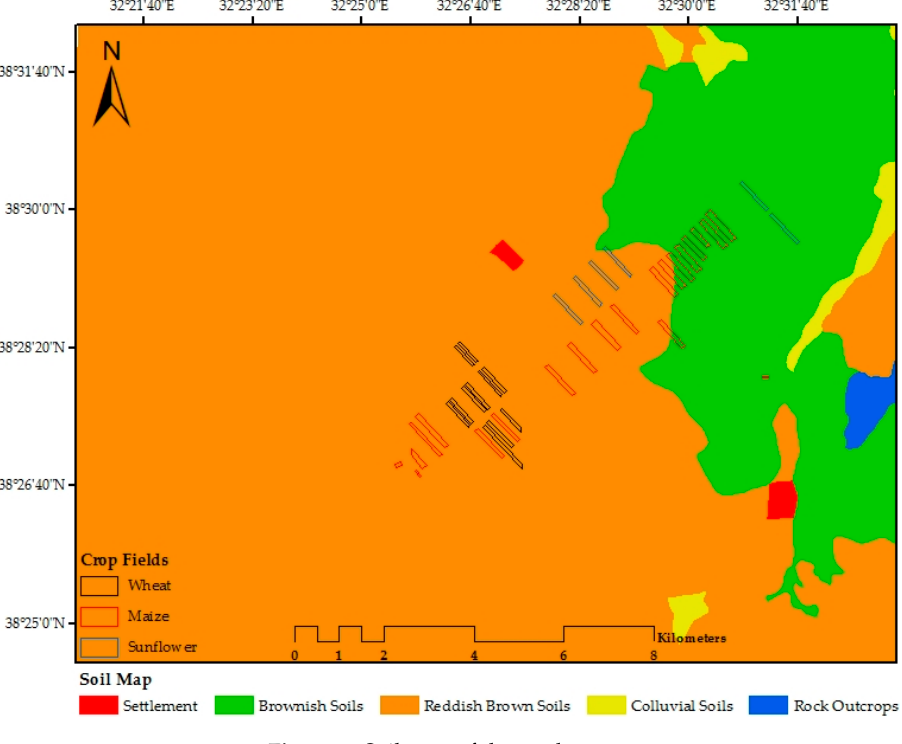
Figure 2. Soil map of the study area.